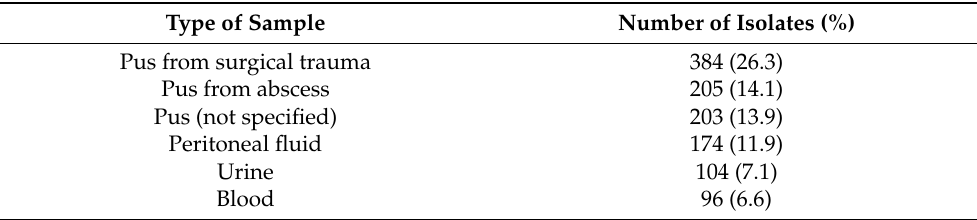
Table 1. Types of cultures sent to microbiology and number of isolates